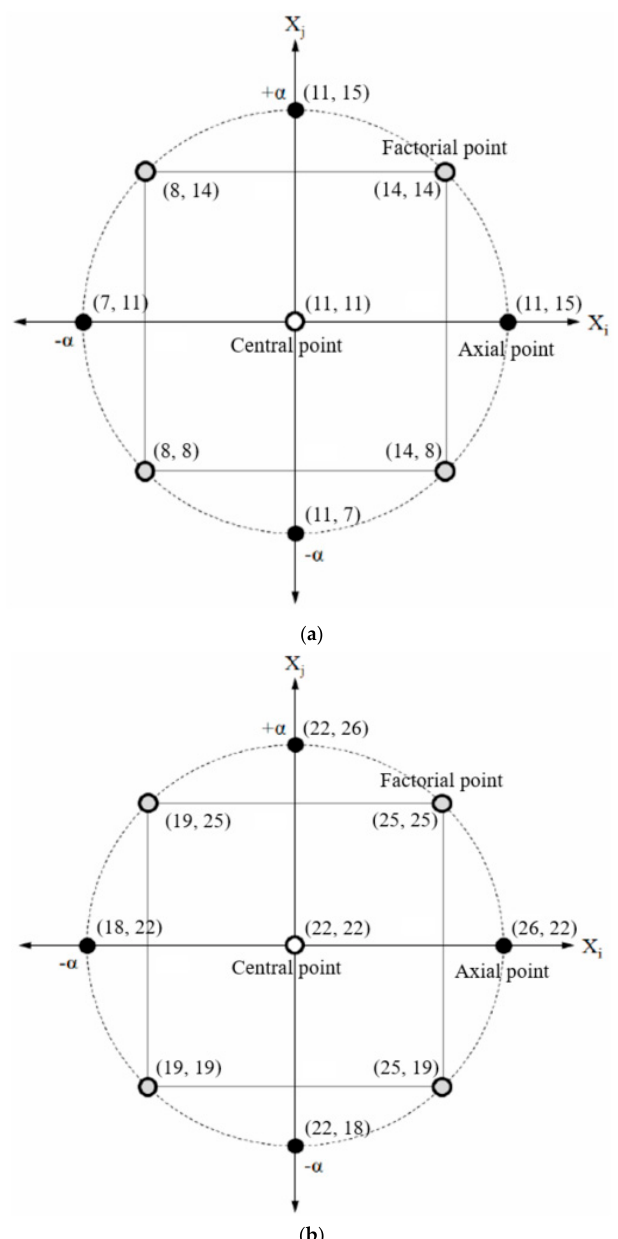
Figure 6. Training point of central composite design sets. ( a ) Design variables and ranges of impeller; ( b ) Design variables and ranges of diffuser.